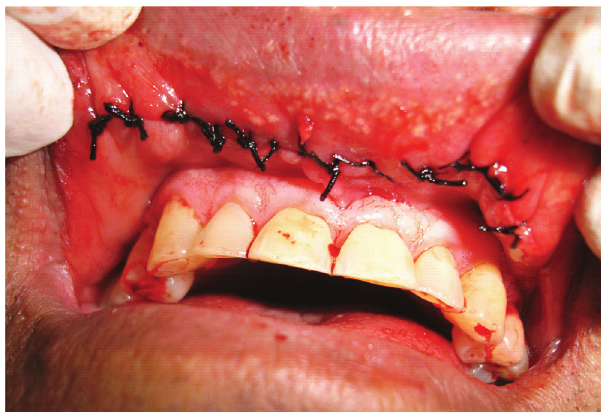
Figure 3 - The “acessory” lip removed and sutured